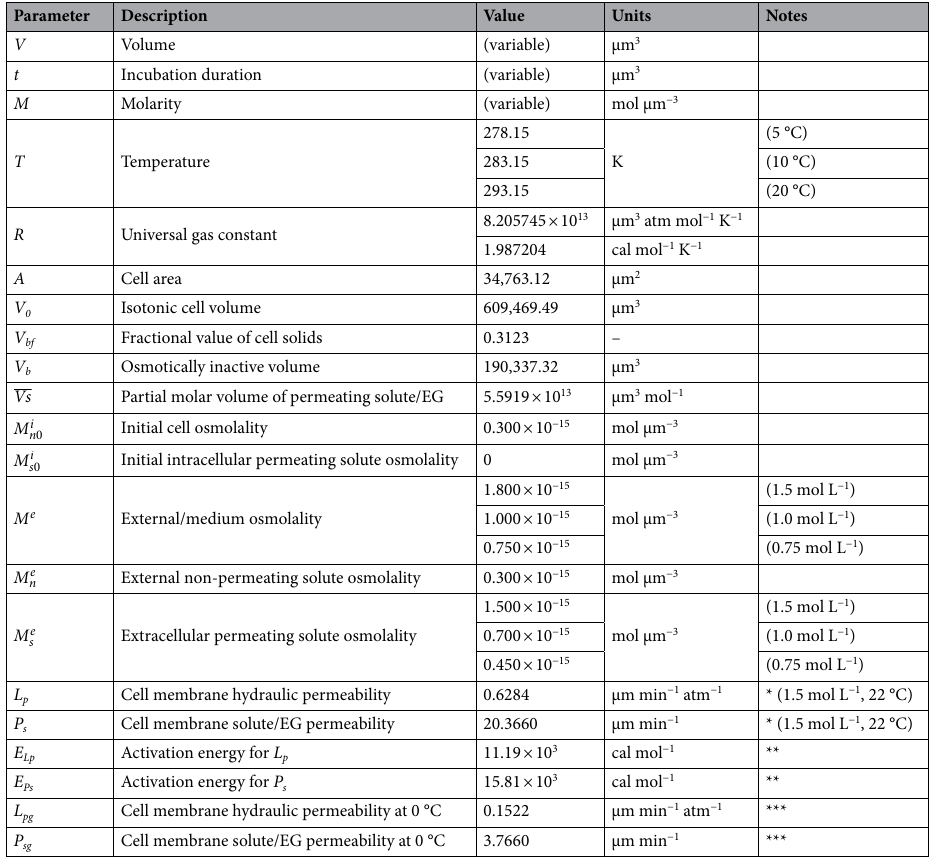
Table 1. Parameters and values used for 2-parameter fitting and modeling of equine oocyte volume responses towards solutions containing various EG concentrations. w: water, s: permeating solute, n: non-permeating solute, o: initial value. e: extracellular, i: intracellular. * L p and P s values were experimentally derived for exposure to 1.5 M EG, at room temperature, as described previously 18 . These values were also applied for calculating volume changes in response to exposure to other EG concentrations. **The values were obtained from the literature 8 . ***Furthermore, these values were used in Eqs. (7) and (8) for deriving L pg , E Lp , as well as P sg and E Ps values; for calculating L p and P s values at different